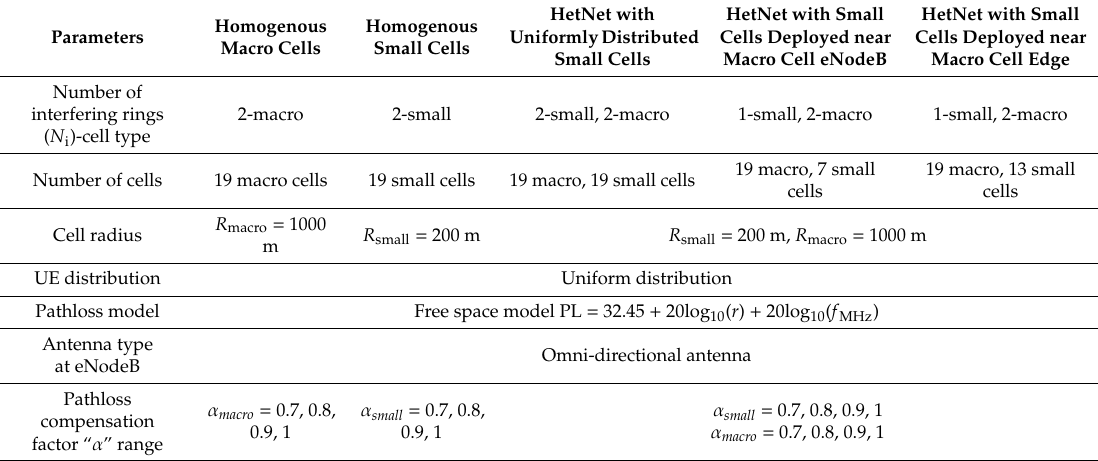
Table 1. System and simulation parameters for each small cell deployment